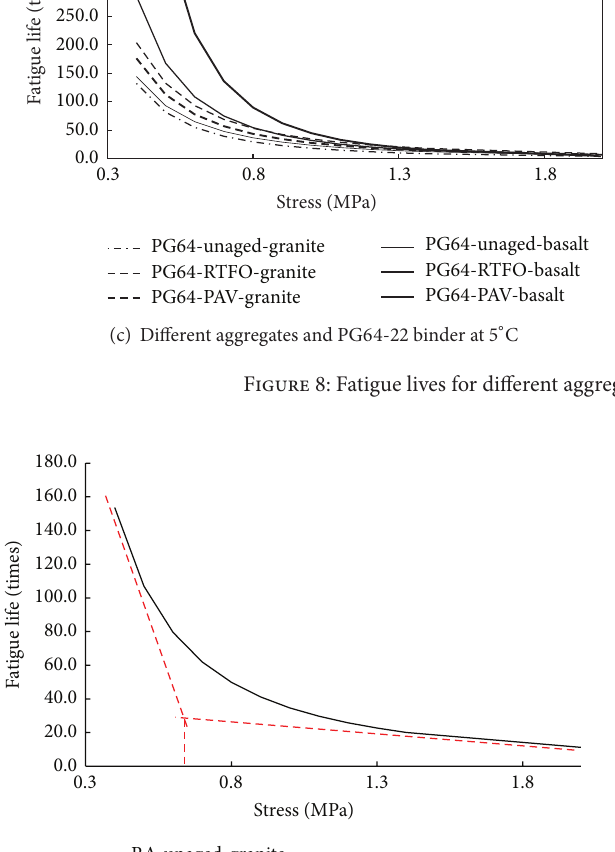
(PG64-22). As to the modified asphalt (rubber asphalt), the adhesion performance between asphalt and aggregate is more dependent on the asphalt